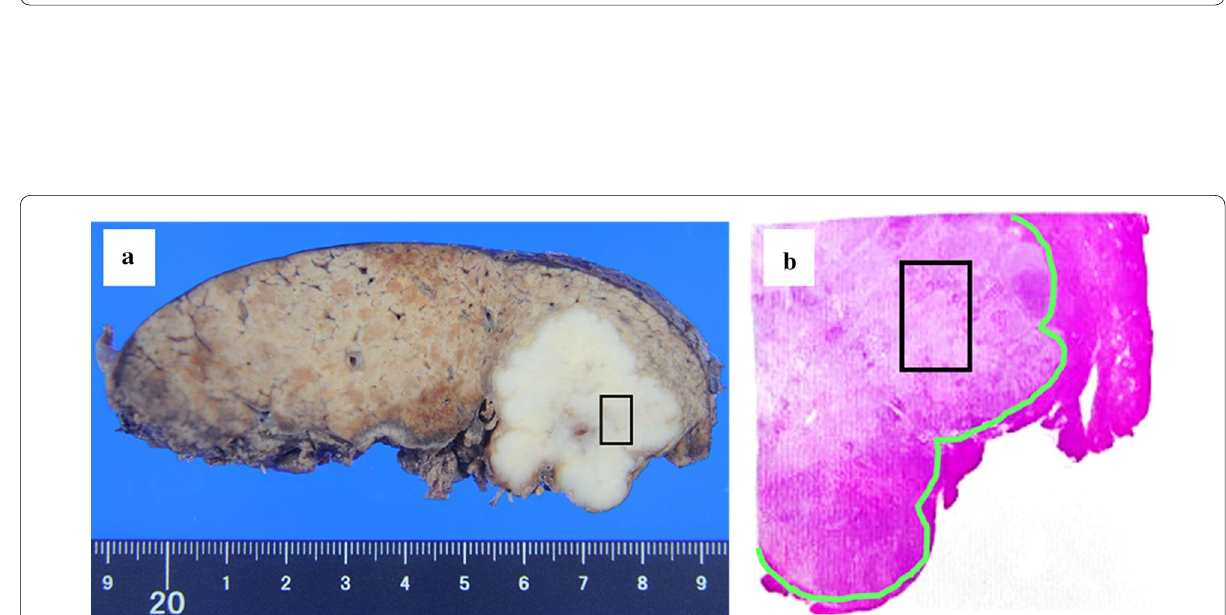
Fig. 3 Imaging. a Gross appearance of the cut surface showing a solid whitish mass measuring 35 mm the area surrounded by the black line on a and b , clear cells are abundantly